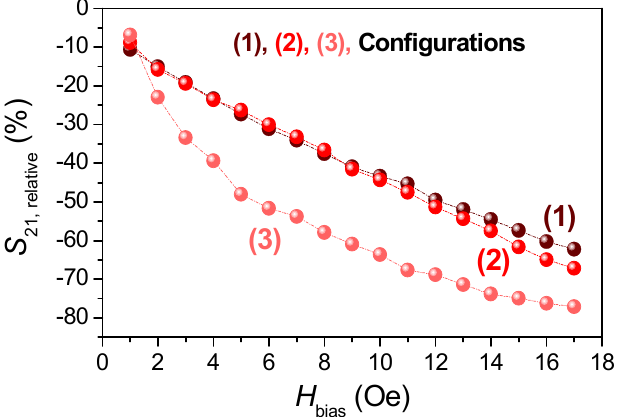
Figure 5. Representation of the S 21, relative as a function of the DC axial magnetic field from 1 to 17 Oe for the three linear array configurations represented in Figure 4a1–a3.